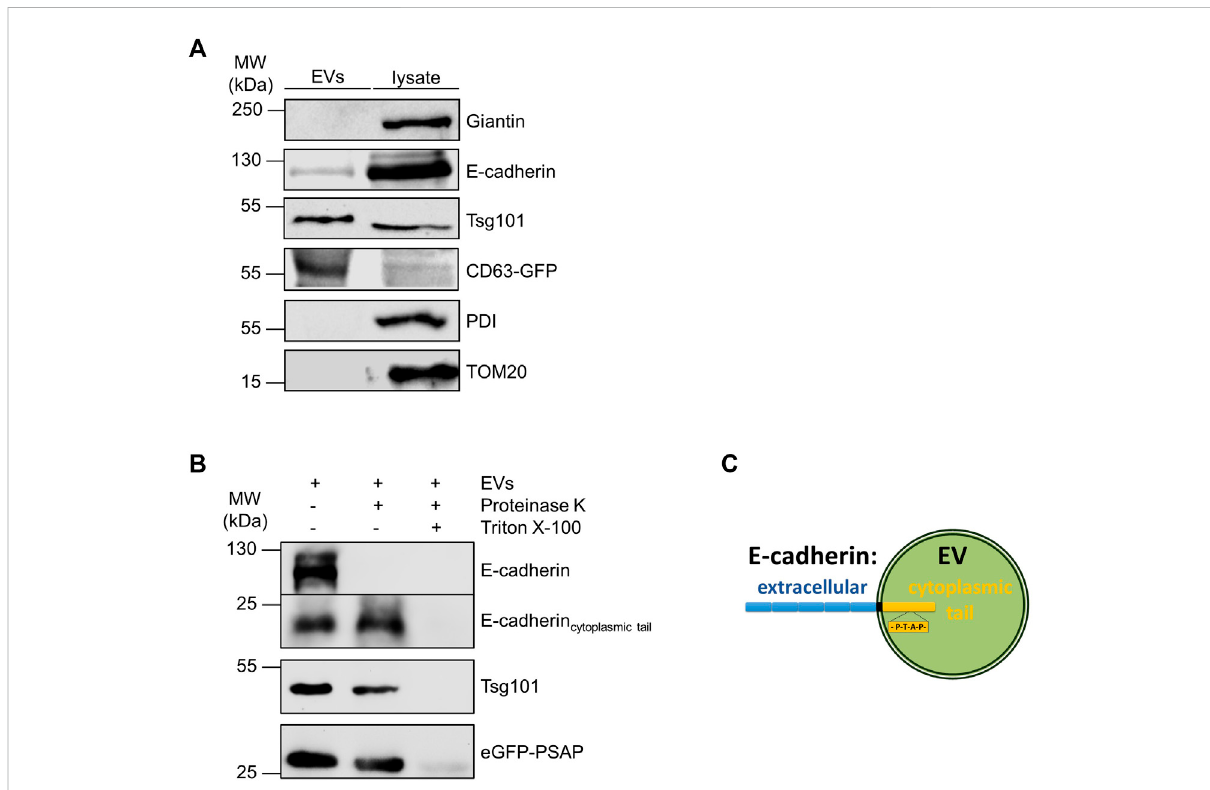
FIGURE 3 Identi fi cation of E-cadherin on isolated EVs. (A) Western blotting analysis of EV fractions and cell lysates. Representative results, n = 3 independent experiments. EVs and the corresponding cell lysates were analyzed by immunoblot with antibodies directed against E-cadherin and Tsg101. Antibodies directed against giantin (Golgi), PDI (ER) and TOM20 (mitochondria) were used as negative controls to validate the purity of EV- isolation. EVs isolated from MDCK CD63-GFP cells were immunoblotted with anti-GFP antibodies and used as positive controls. (B) Proteinase protection assay. Antibodies directed against the cytoplasmic tail of E-cadherin were used for E-cadherin staining. Antibodies directed against Tsg101 and GFP were used as indicated. Representative results, n = 3 independent experiments. (C) Schematic drawing of the orientation of E-cadherin in the exosomal membrane. Schematic drawing of the orientation of E-cadherin in the membrane of an extracellular vesicle (EV). The extracellular part of the protein is shown in blue, and the part directed to the interior of the vesicle is shown in yellow.